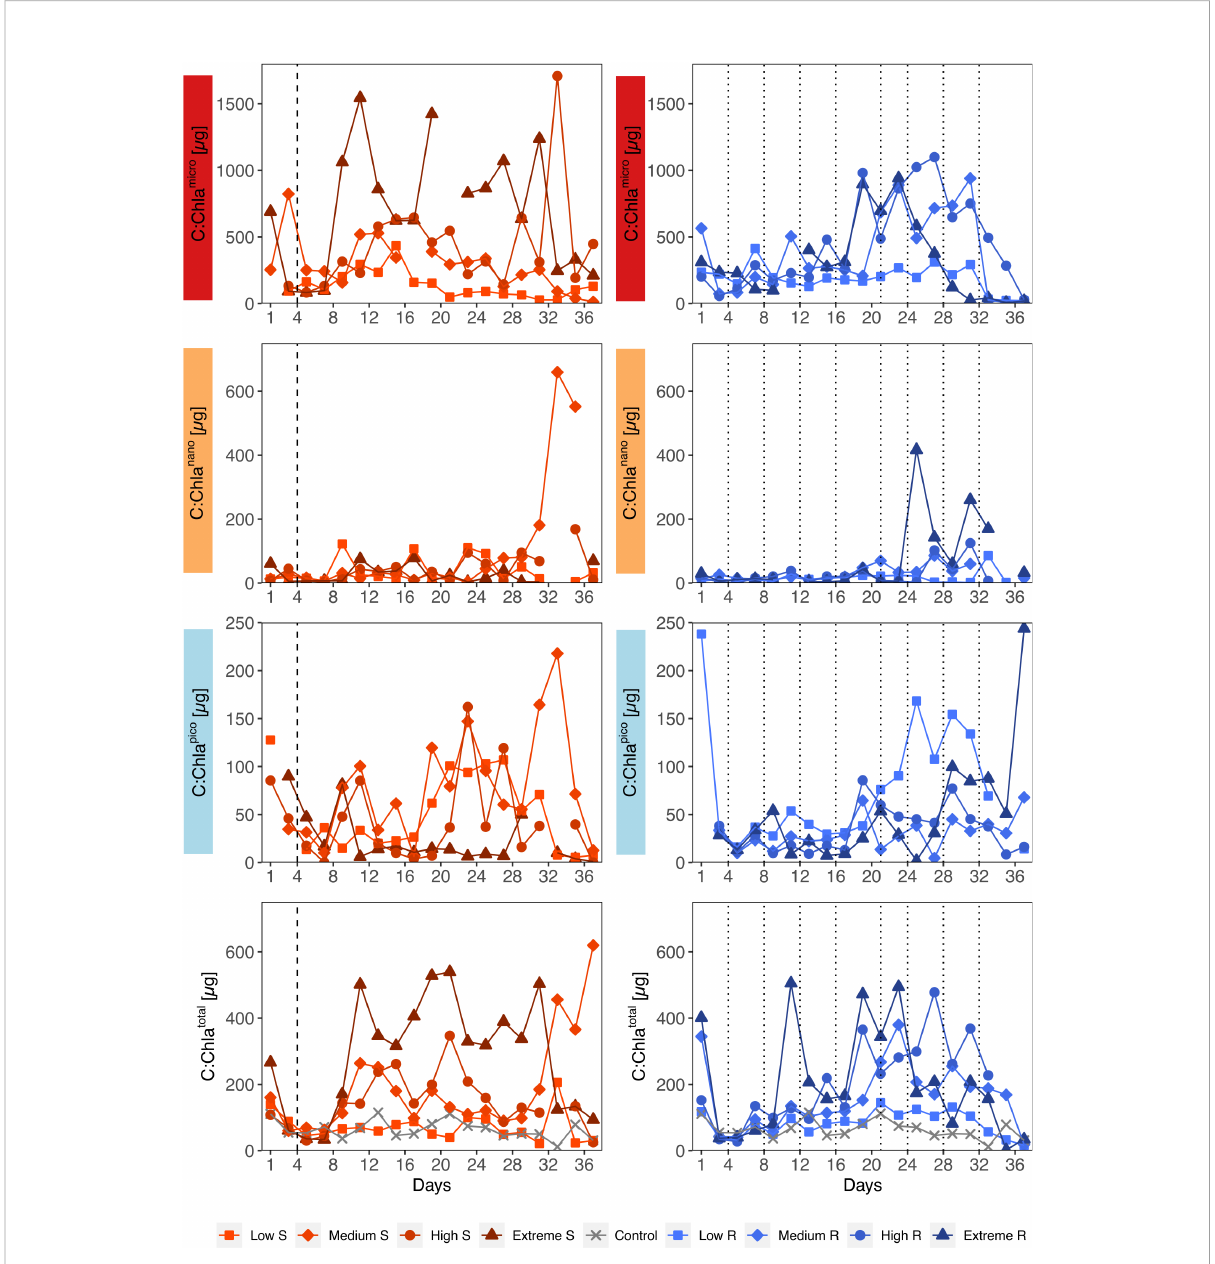
FIGURE 5 Temporal development of carbon to chlorophyll ratios (C:Chla) separated by size fractions and upwelling mode. S, Singular; R, Recurring. Mind the different y-axis scales. Dotted lines represent DW additions, dashed line marks the single DW addition to singular